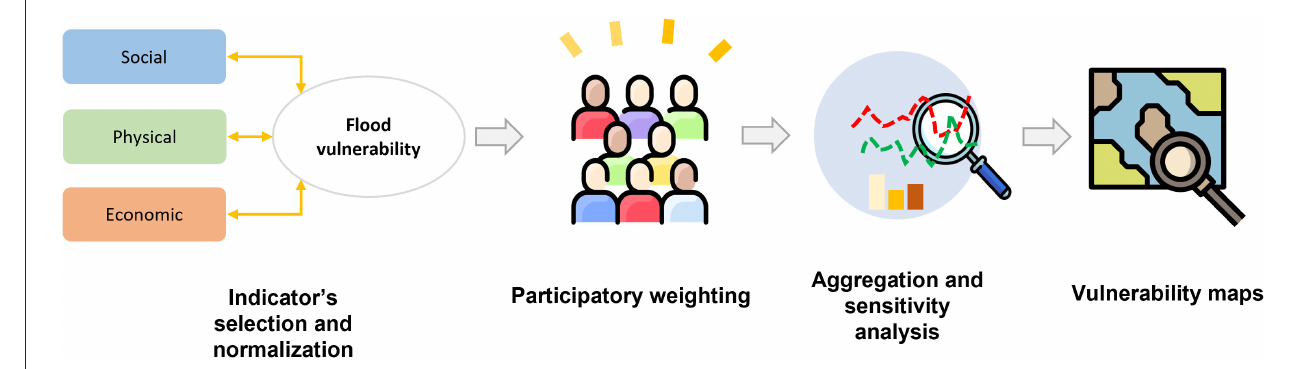
FIGURE1 Methodological approach adopted in this